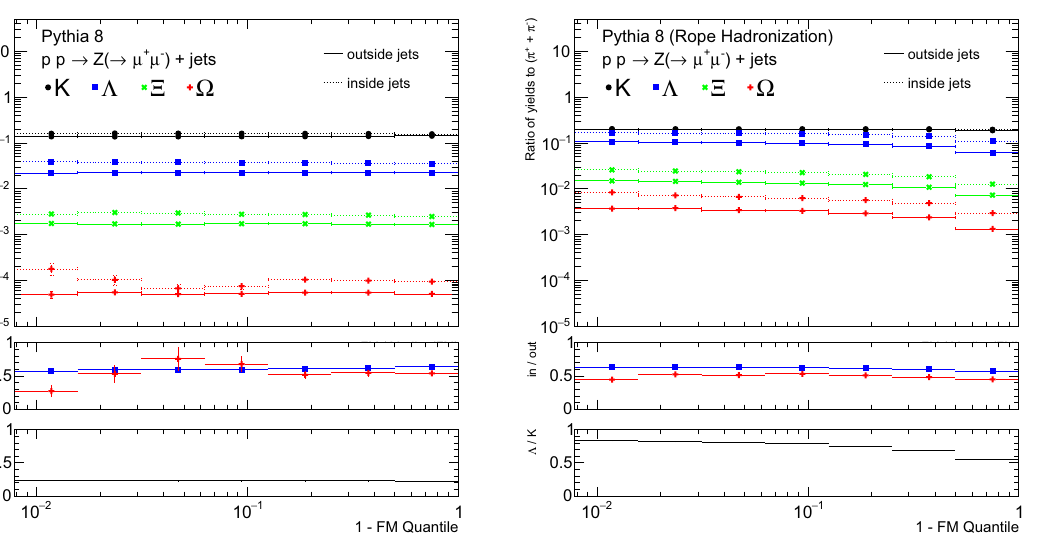
which is consistent with the ALICE forward scintillators [99] and ATLAS/CMS forward calorimeters